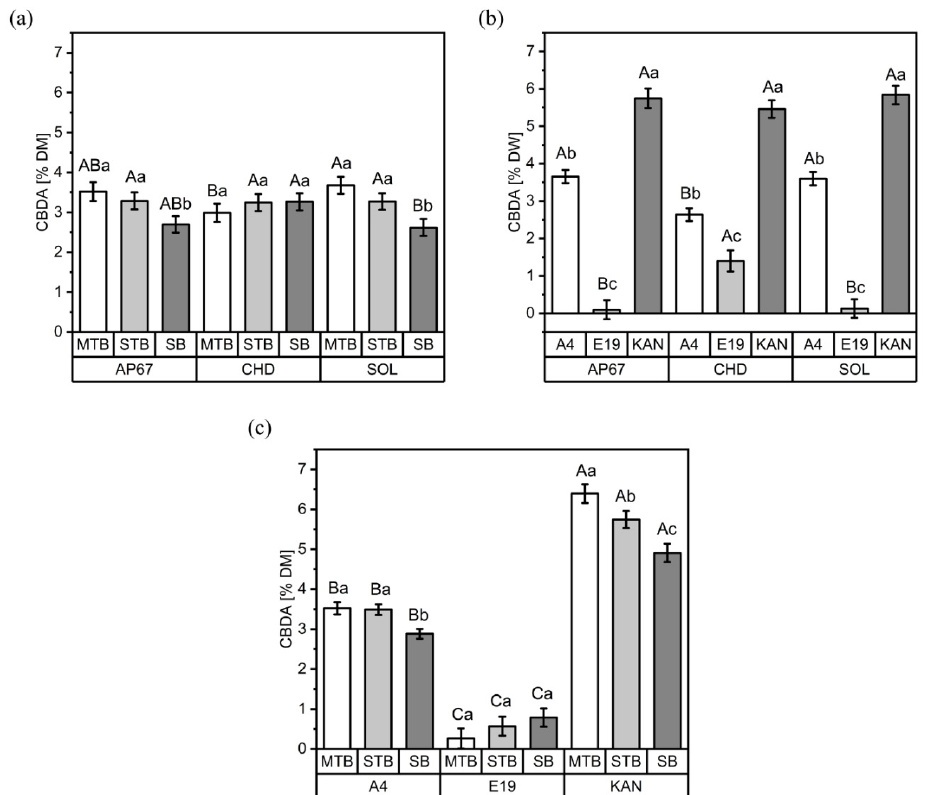
Figure 3. CBDA concentrations (% DW) for the three flower positions (MTB: main top bud, SBs: side buds, STBs: side top buds) under the three light spectra (SOL, AP67 and CHD) ( a ), for the three strains (A4, E19 and KAN) under the three light spectra ( b ) and for the three flower positions of the respective strains ( c ). Means covered by at least one identical letter did not differ significantly, as indicated by a Tukey test ( α = 0.05). Lowercase letters indicate comparisons between flower positions ( a ) or strains ( b ) within light spectra, or flower positions within strains ( c ); uppercase letters indicate comparisons between light spectra within flower positions ( a ) or strains ( b ), or strains within flower positions ( c ). Error bars indicate the standard errors of the means ( n = 3).